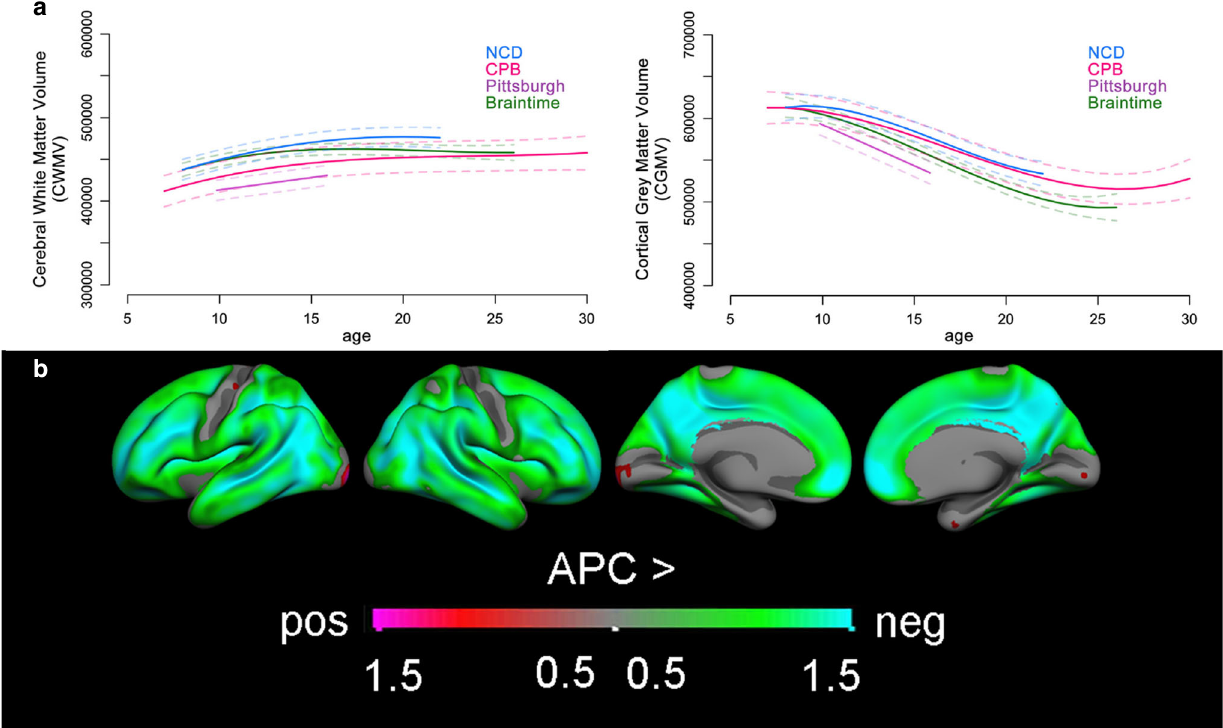
Fig. 1 Longitudinal changes in brain structure across adolescence (ages 8 – 30). a Consistent patterns of change across four independent longitudinal samples (391 participants, 852 scans), with increases in cerebral white matter volume and decreases in cortical grey matter volume (adapted from Mills et al., 2016, NeuroImage 105 ). b Of the two main components of cortical volume, surface area and thickness, thinning across ages 8 to 25 years is the main contributor to volume reduction across adolescence, here displayed in the Braintime sample (209 participants, 418 scans). Displayed are regional differences in annual percentage change (APC) across the whole brain, the more the color changes in the direction of green to blue, the larger the annual decrease in volume (adapted from Tamnes et al., 2017, J Neuroscience 15